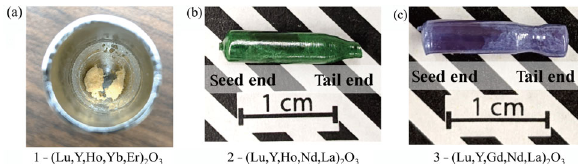
Fig. 6 (a) Top view of the iridium–rhenium crucible with sintered powder of composition 1 that did not melt at the maximum operating temperature of the crucible. (b) Crystal of composition 2. (c) Crystal of composition 3.